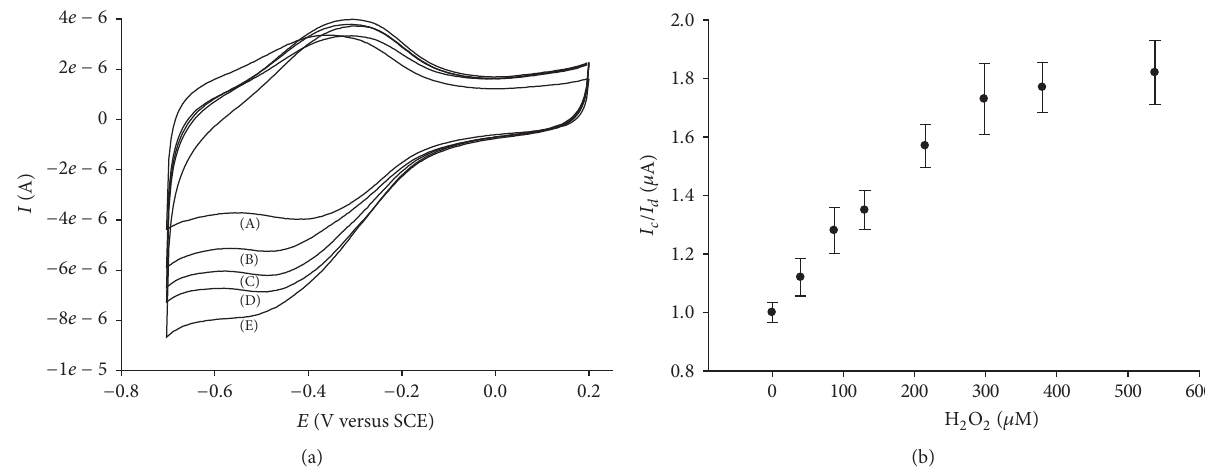
Figure 4: CVs of NAF-MWCNTs-COOH-GCE-CAT modified biosensor in the absence (A) and in the presence of 130 𝜇 M (B), 215 𝜇 M (C), 298 𝜇 M (D), and 538 𝜇 M (E) of the substrate H 2 O 2 (a). Catalytic efficiency changes versus hydrogen peroxide, where 𝐼 𝑐 and 𝐼 𝑑 are the cathodic peak currents in the presence and in the absence of H 2 O 2 , respectively (b). Experimental conditions: deoxygenated PBS buffer solution, V = 50 mVs −1 .